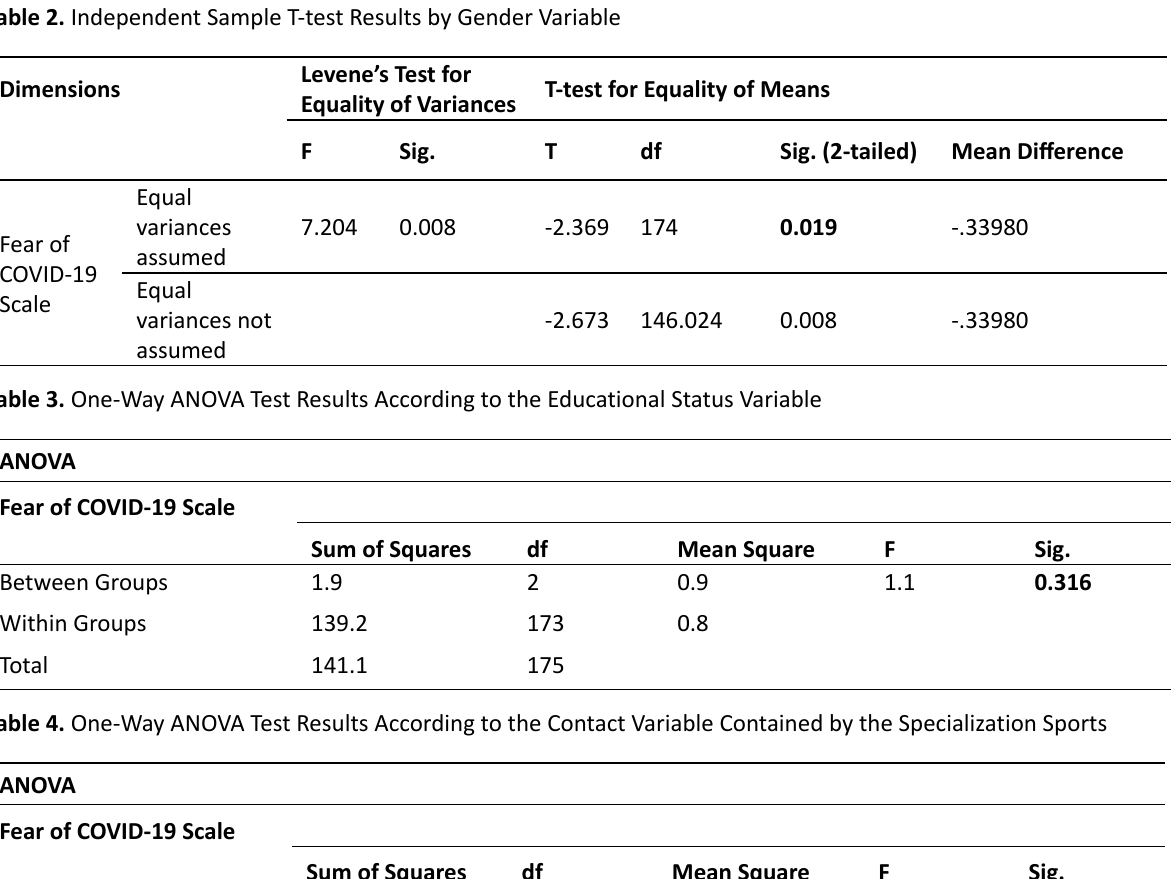
Table 2. Independent Sample T-test Results by Gender Variable Dimensions